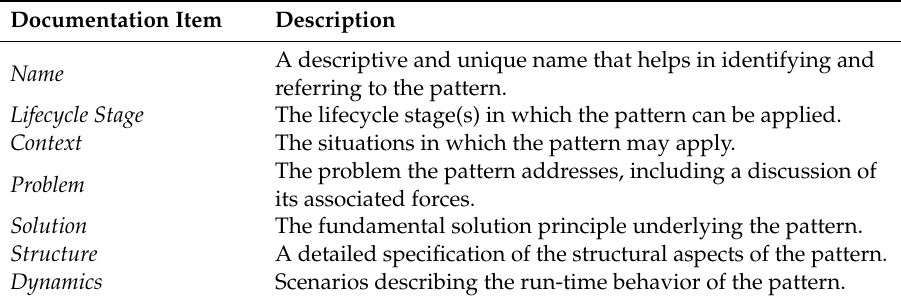
Table 3. Documentation template for patterns.